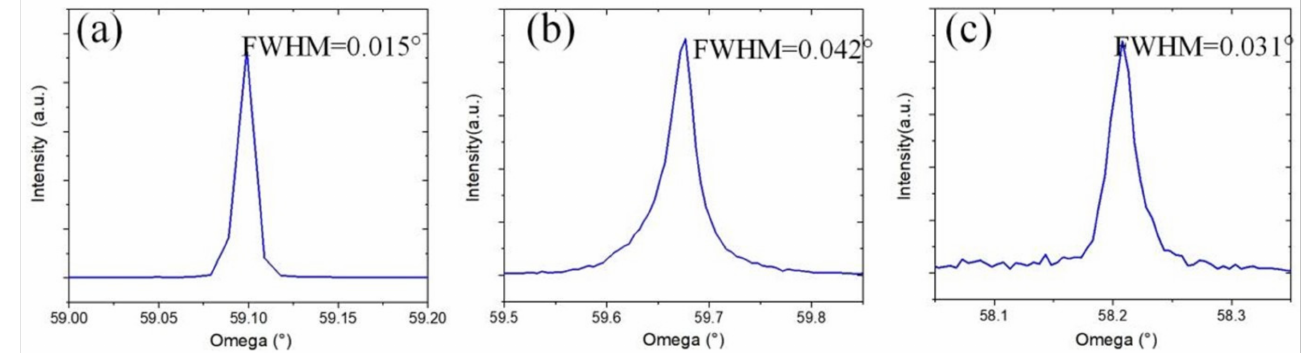
Figure 6. XRD scanning: ( a ) SCD substrate; ( b ) vertical microchannel; ( c ) reverse-V-shaped